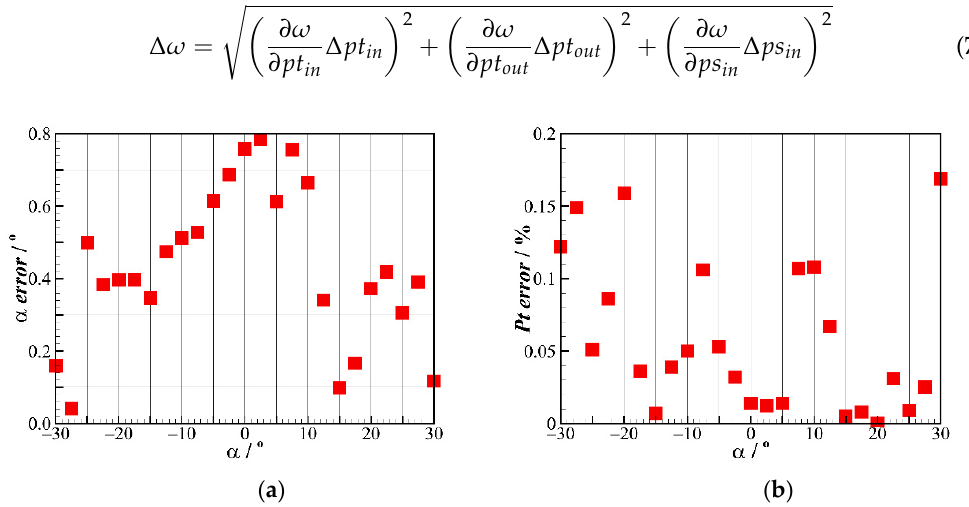
Figure 6. Measurement error of five-hole probe. ( a ) Yaw angle; ( b ) total pressure. The boundary conditions were defined according to the experimental conditions. The average back pressure at the outlet was set to atmospheric value, and the solid surfaces were set to adiabatic and non-slip walls. The total temperature was 320 K at the inlet, where the total pressure was adjusted to maintain an inlet Mach number of 0.7. The inlet boundary layer was measured by the total pressure boundary layer probe and normalized by the maximum value. The thickness of the boundary layer ( δ ) was 8.1 mm, as shown in Figure 7. The distribution of inlet normalized total pressure was fitted as Equation (7), and its R-square was 0.9999: